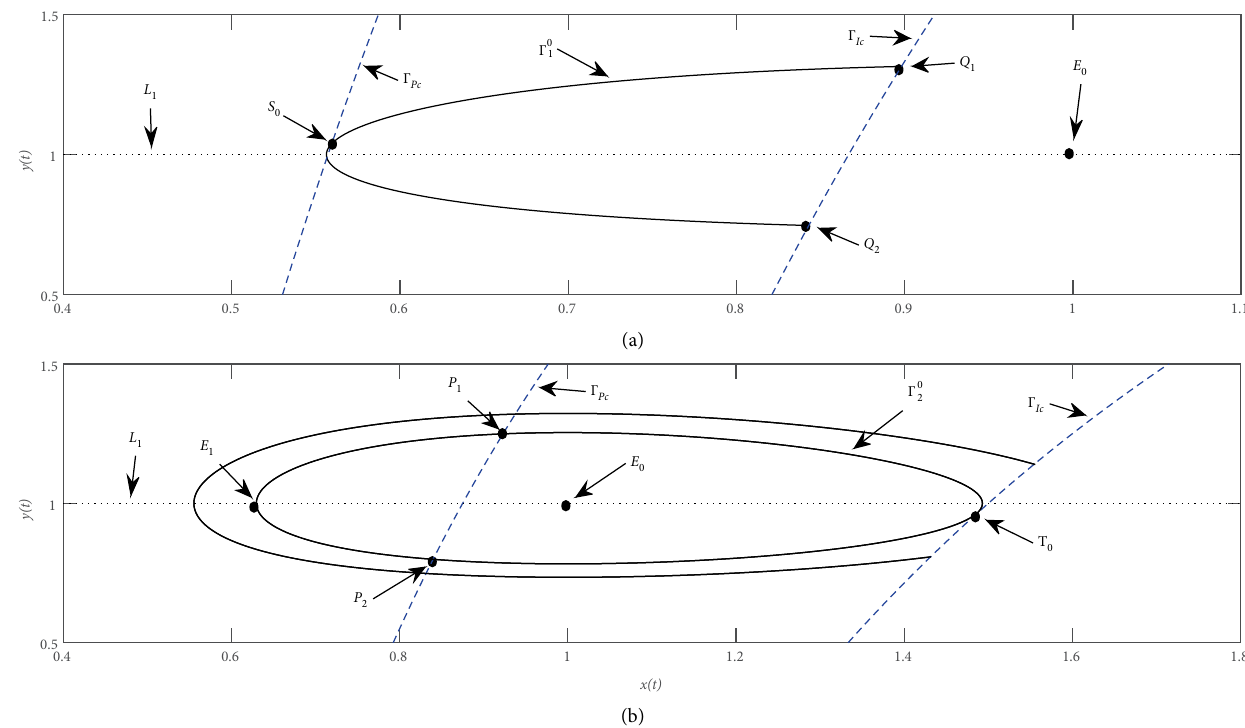
0 . is a trajectory 1 Γ